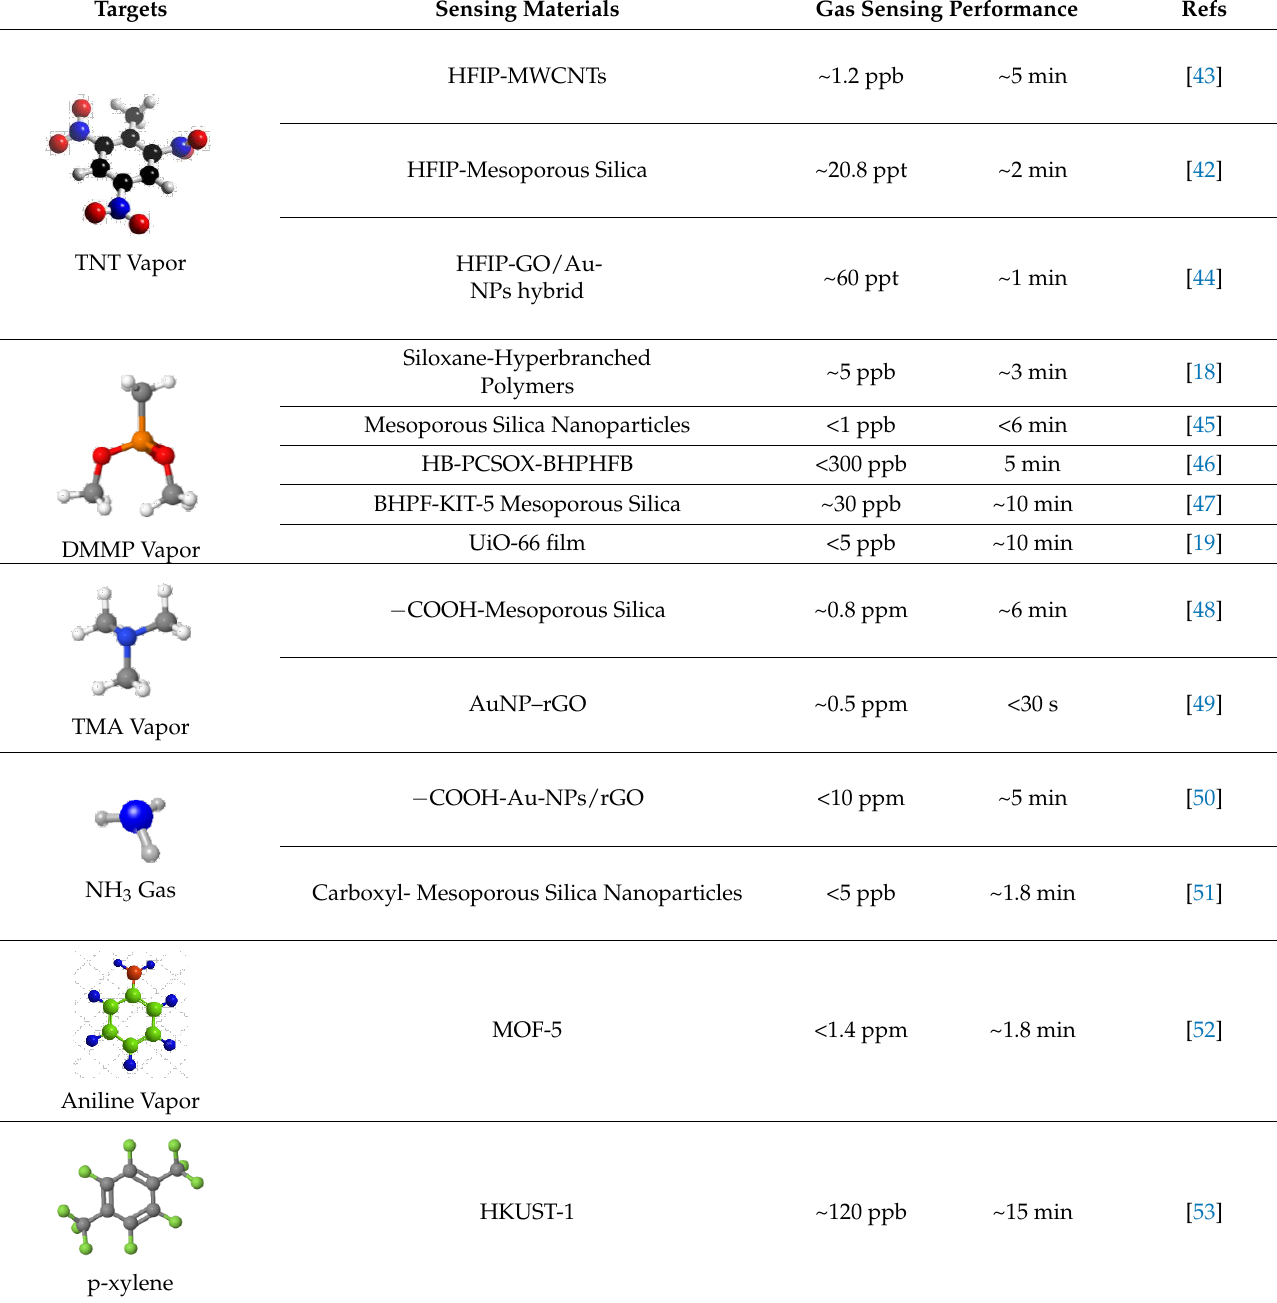
Table 2. Integrated Resonant Gravimetric Sensors for Gas Sensing.